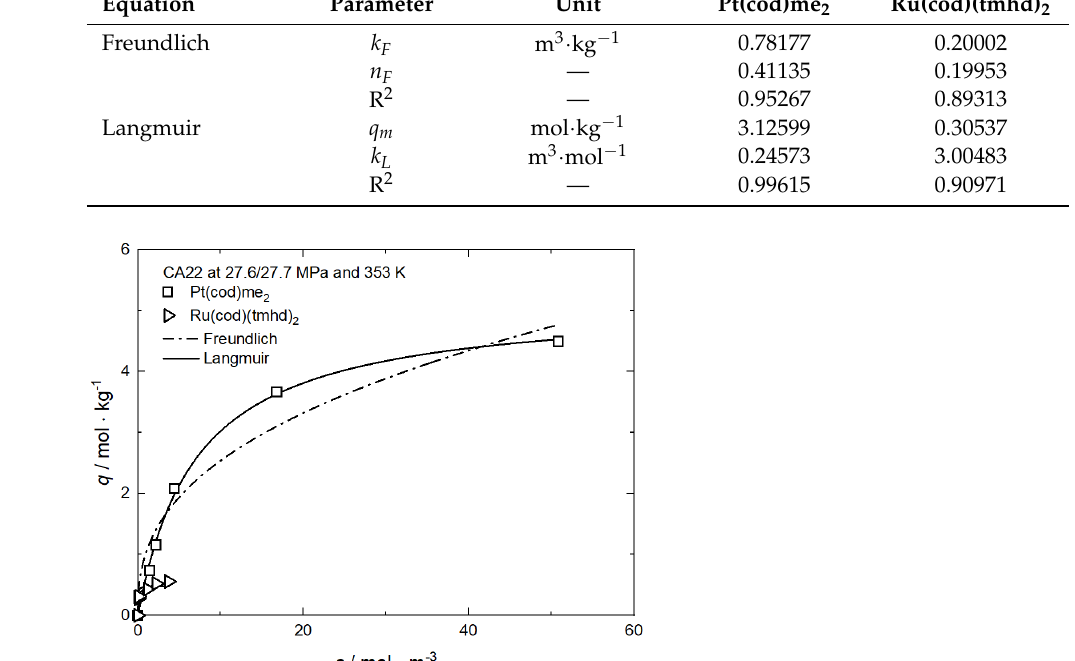
Figure A19. Uptake of different precursors on CA22 at 27.6/27.7 MPa and 353 K; experimental data taken from [37,63].